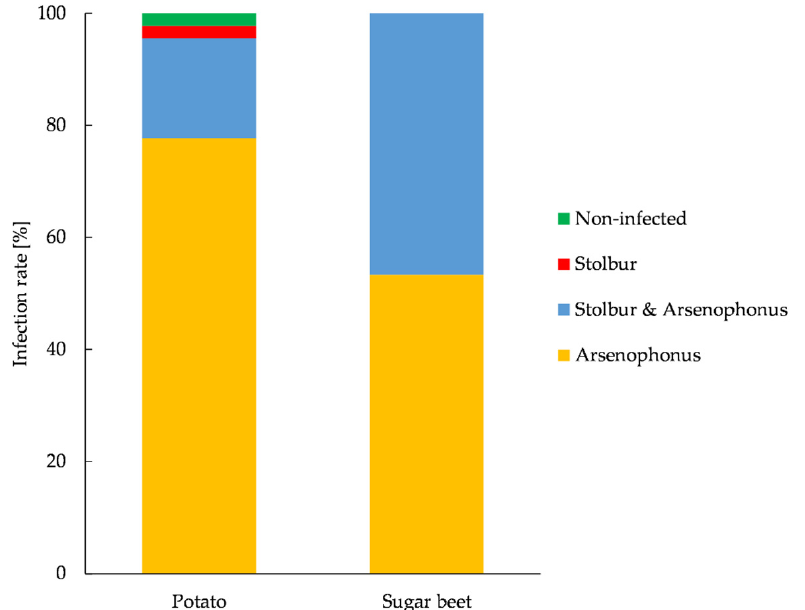
Figure 5. Prevalence of Candidatus Arsenophonus phytopathogenicus (Arsenophonus) and Candidatus Phytoplasma solani (stolbur) in symptomatic potato tubers (n = 45) and sugar beet roots (n = 30), in September 2022.